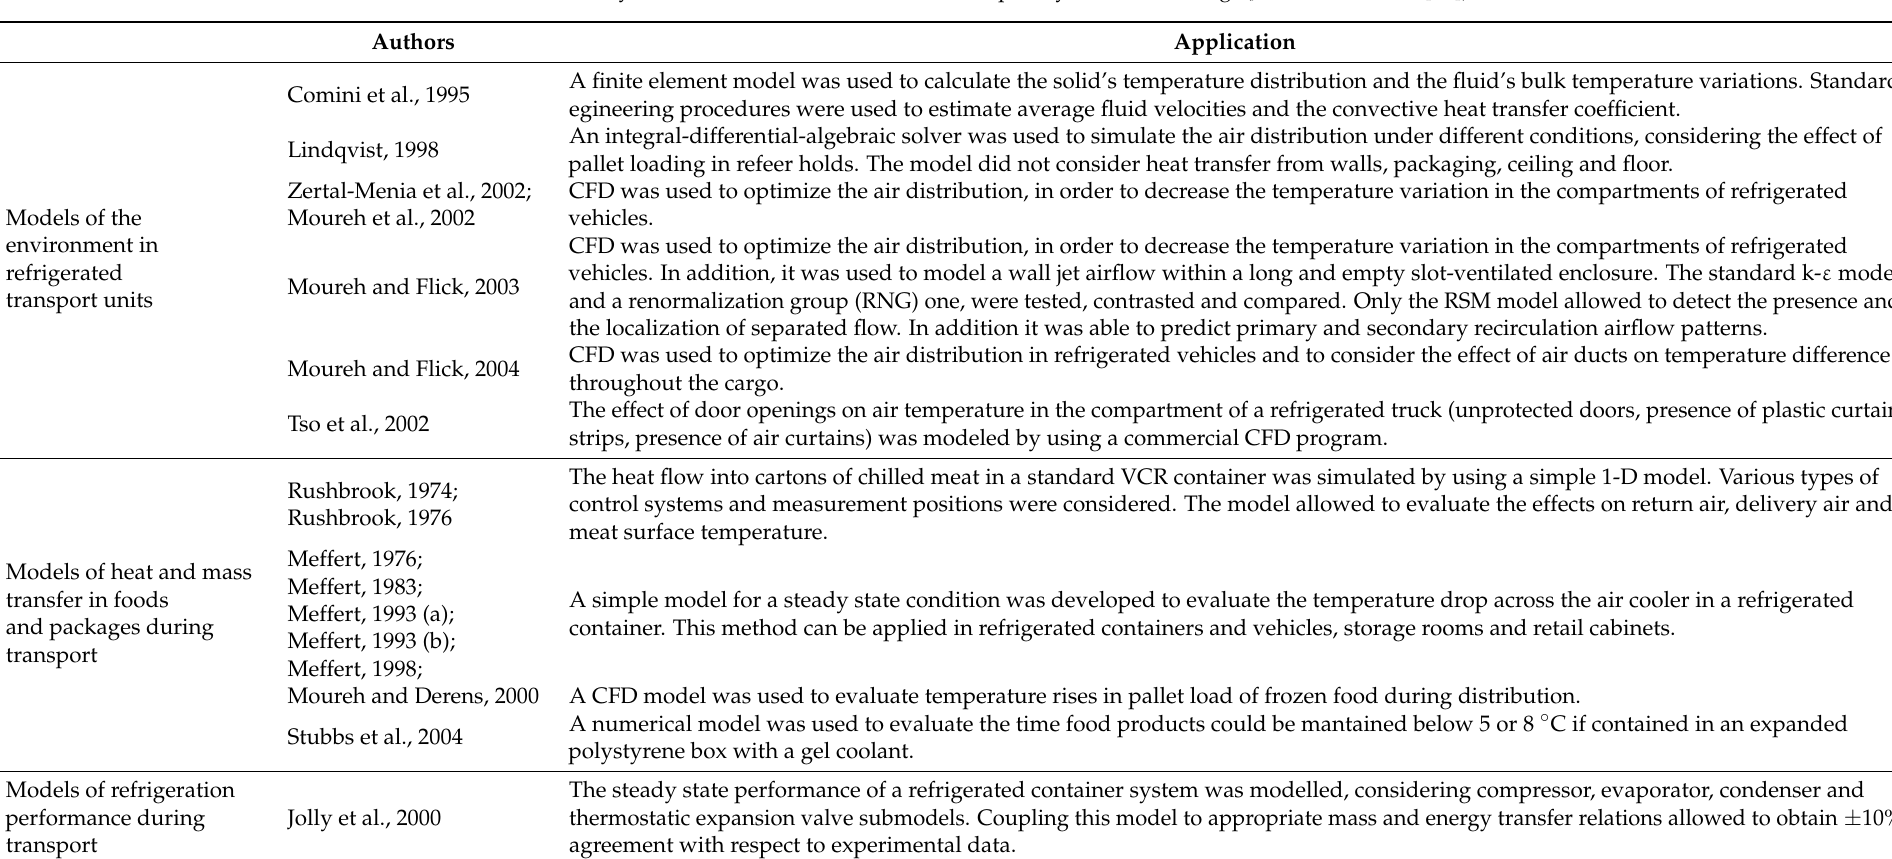
Table A1. Summary of reviewed articles about land transport systems modelling. (James et al., 2006